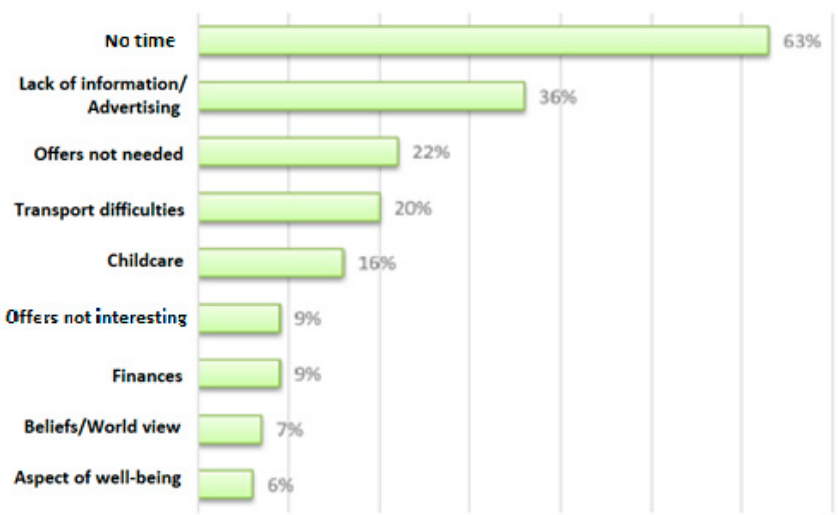
Figure 7. Obstacles to the use of family support services (percentage of all valid, multiple answers; percentage data). (Source: Authors,